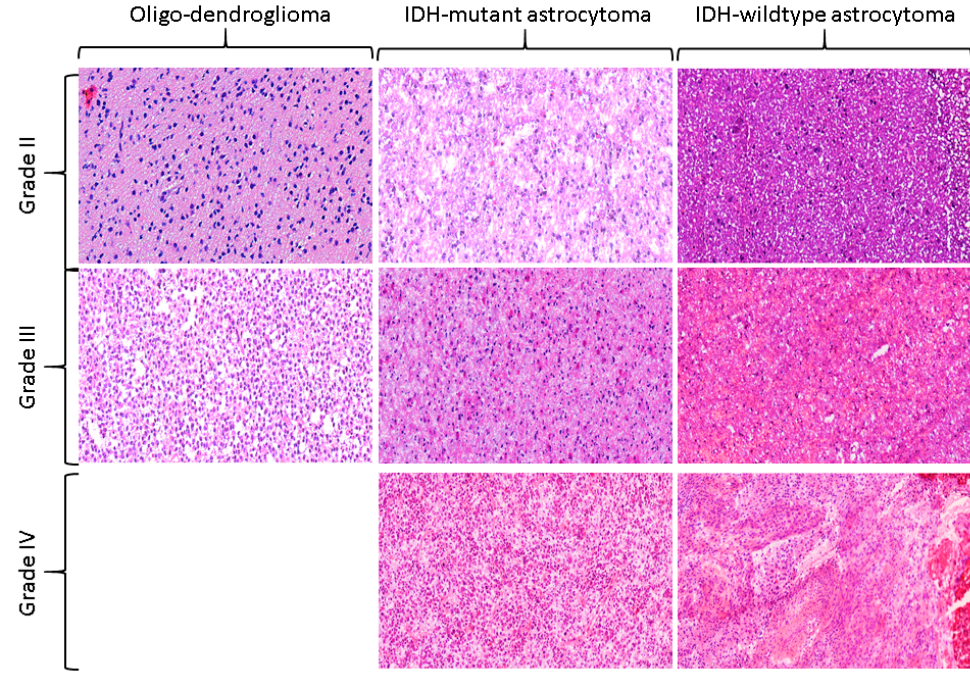
Figure 1. The World Health Organization (WHO) classification of cancer grades. IDH-wildtype astrocytoma is characterized by the absence of both IDH and 1p/19q mutation status, IDH-mutant astrocytoma is defined by the presence of IDH but the absence of 1p/19q, and oligodendroglioma is defined by the presence of both IDH and 1p/19q. Cancer grades are then assigned based on the histologic descriptors of mitotic activity, microvascular proliferation, and pseudopalisading necrosis. The images were acquired using 20 × magnification